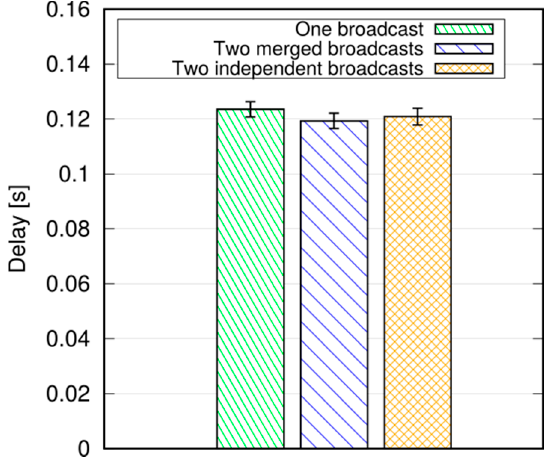
Figure 20. 95th percentile of delay with multiple broadcast sources.